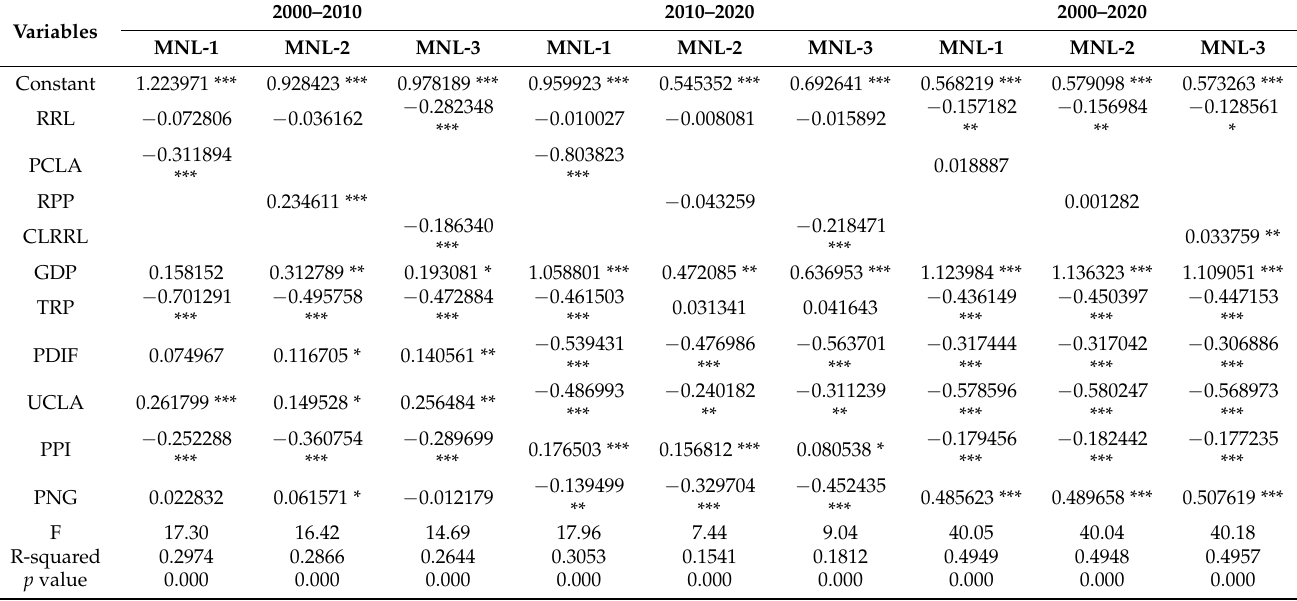
Table 8. Regression results of CLUE (including mediating variables).